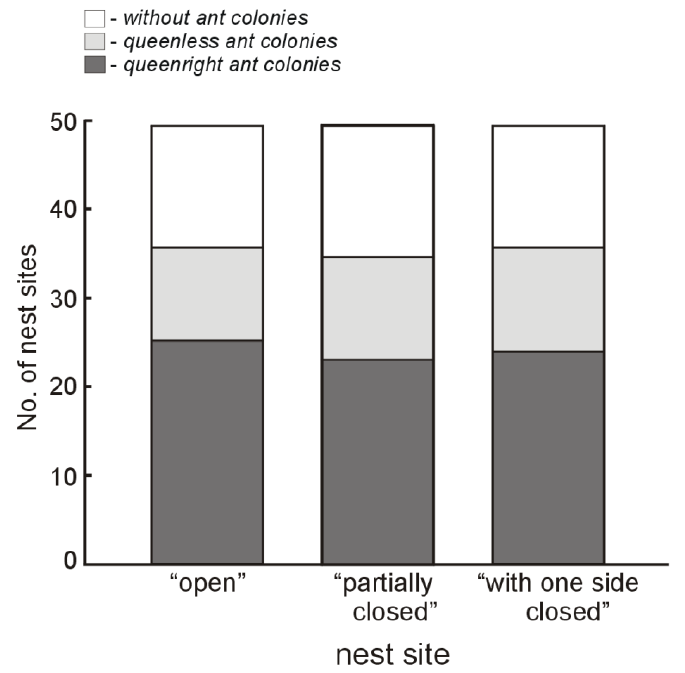
Figure 5. Number of artificial ‘open’, ‘partially closed’, and ‘with one side closed’ (see Figure 1) nest sites in which Temnothorax crassispinus ant colonies (queenright and queenless, respectively) or no ant colonies were found. As part of the field experiment, 50 artificial nest sites from each of the three groups were set in place in early spring 2020 and were then collected about two months later. Three of the nest sites (one from each group) were not included in the analysis, as during the experiment they had been pushed into the ground and their holes were blocked with soil.